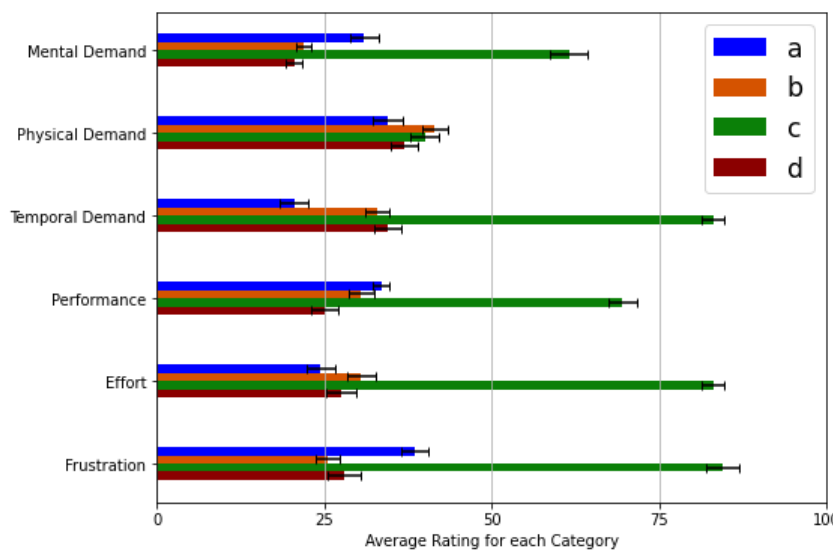
Figure 12. Mean of the results gathered from the volunteers. Where ( a ) is the sEMG PR UPI; ( b ), the one using the buttons and the Myo; ( c ) is the version using the camera; and ( d ) is the iteration with reduced contractions